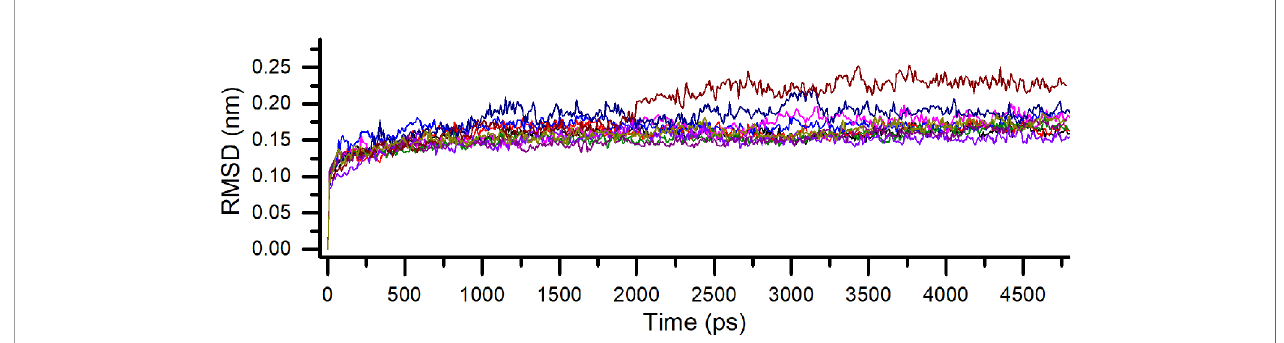
FIGURE 2 | Comparative root-mean-square deviation (RMSD) for all binding poses of compound 1 on PDE4A and PDE4B. Each pose is indicated by a different